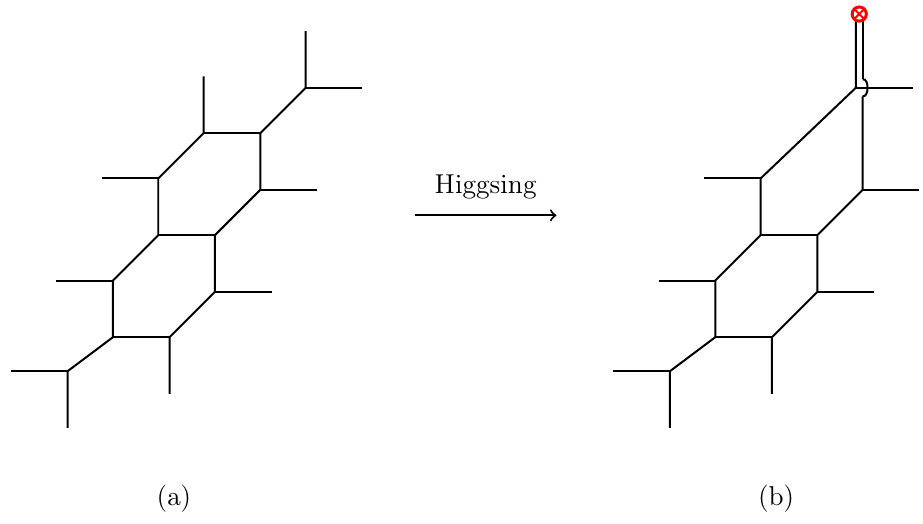
Figure 8 . Higgsing from (a) SU(3) , N f = 6 theory to (b) SU(2) , N f = 5 theory. function of